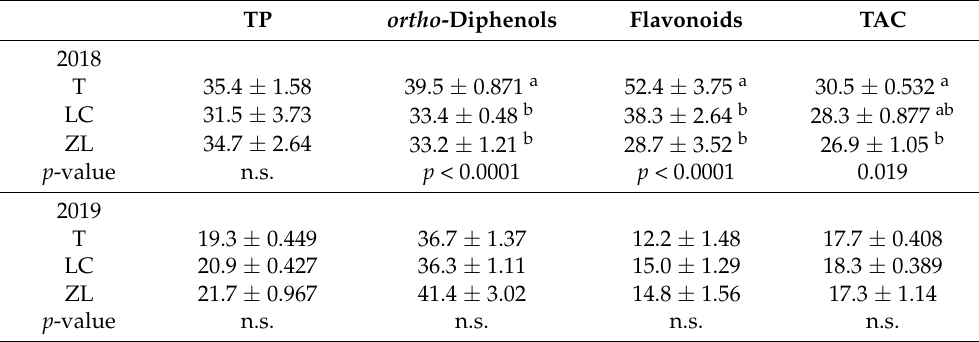
Table 2. Olive fruit metabolite concentration as a function of soil management treatment and harvest